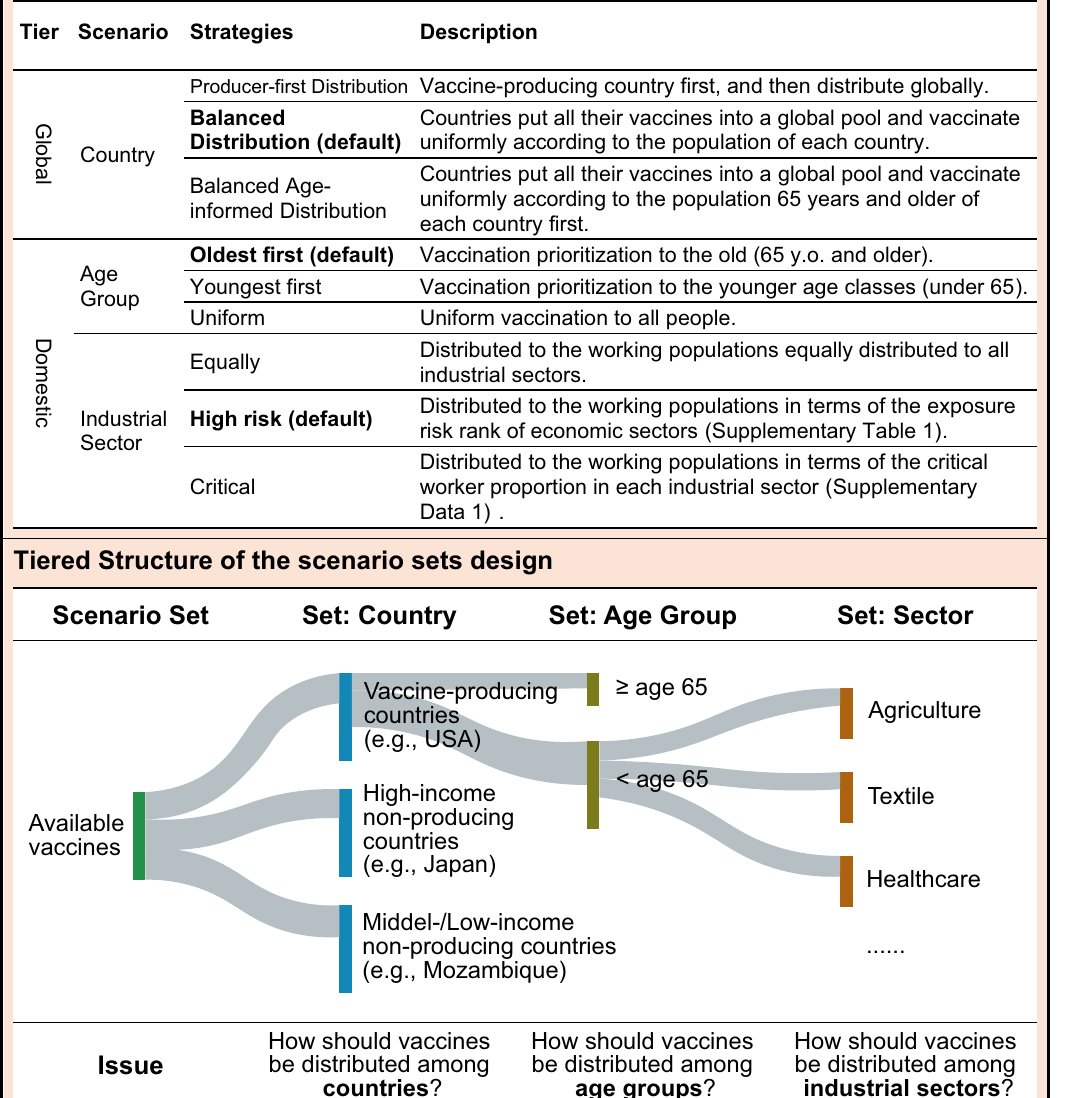
within each destination country. Among Tier Domestic, sub-scenario A de fi nes the allocationofthereceivedvaccineswithindestinationcountriesbyagegroup,while sub-scenario S de fi nes the allocation of the received vaccines within destination countries by industrial sectors. One scenario involves a decision at the tiered sce- nario set, one of which is global and the other 2